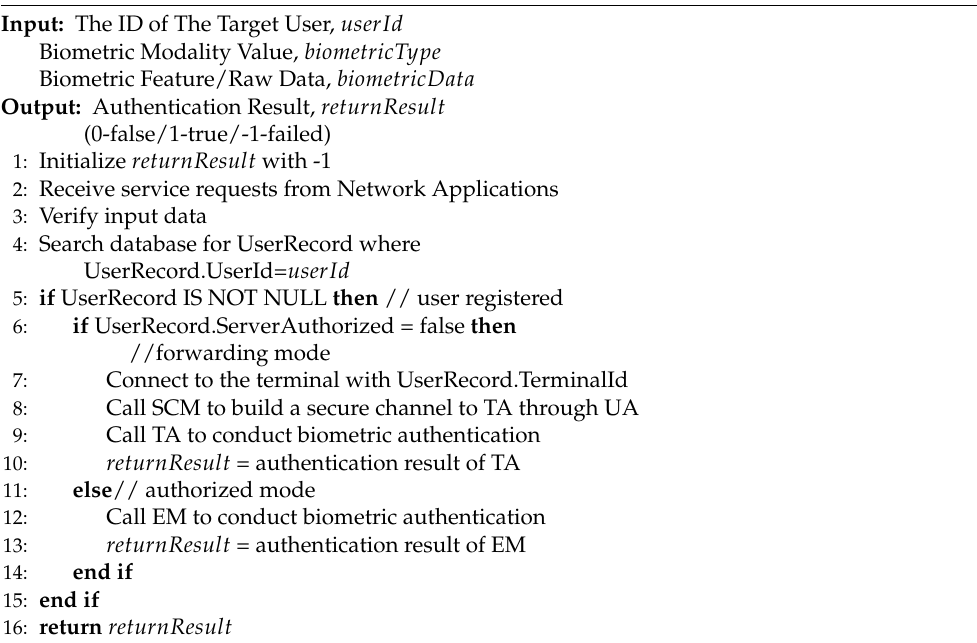
Algorithm 2 Process for Handling Service Requests from Network